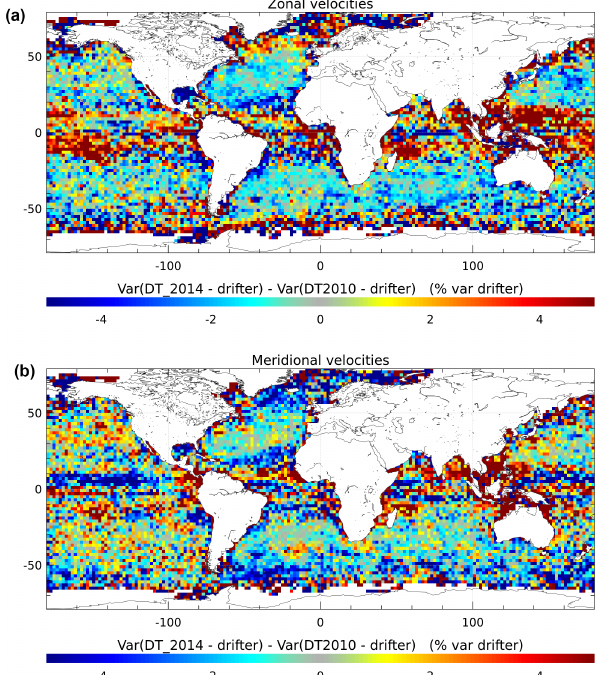
Figure 12. Maps of the difference of the variances of the altime- ter geostrophic currents minus drifter measurement differences, us- ing successively DT2014 and DT2010 SLA gridded products. The difference of variance is expressed in % of the drifter variance. Zonal (a) and meridional (b) component differences. Negative val- ues mean that the variance of the differences between geostrophic currents from altimetry and from drifter measurement is reduced when considering the DT2014